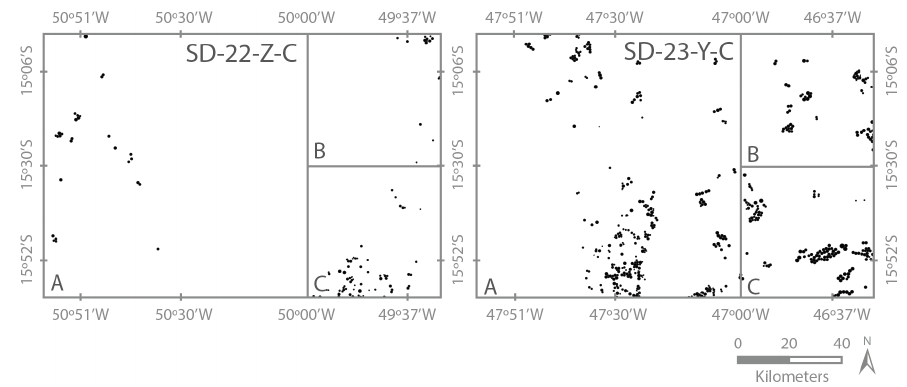
Figure 2. Samples collected in Regions A and B were used during the training process to train and to validate the model, respectively. The samples collected in Region C were used to evaluate the model during the accuracy analysis. Labeled center pivot irrigation systems are shown in